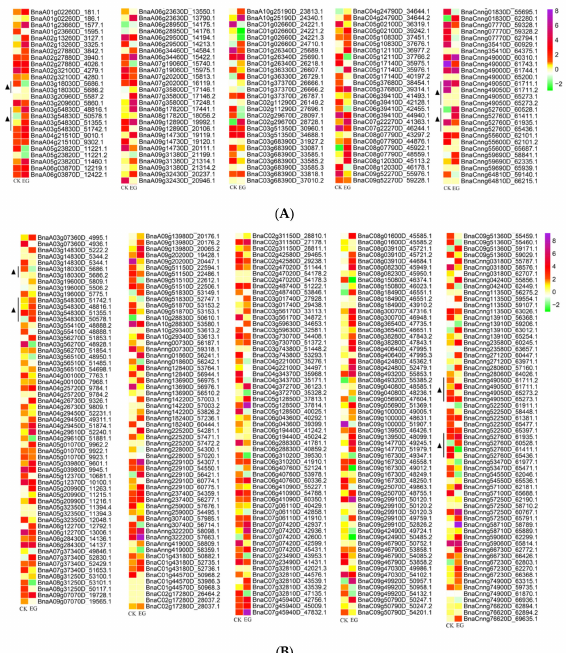
Figure 5. Heatmap of the isoform expression levels of the di ff erentially expressed genes of mock-infected and infected materials among the 1892 di ff erentially spliced genes. ( A ) Heatmap of the di ff erentially expressed genes of mock-infected and infected cotyledons. ( B ) Heatmap of the di ff erentially expressed genes of mock-infected and infected stems. CK and EG represent mock-infected and infected materials,